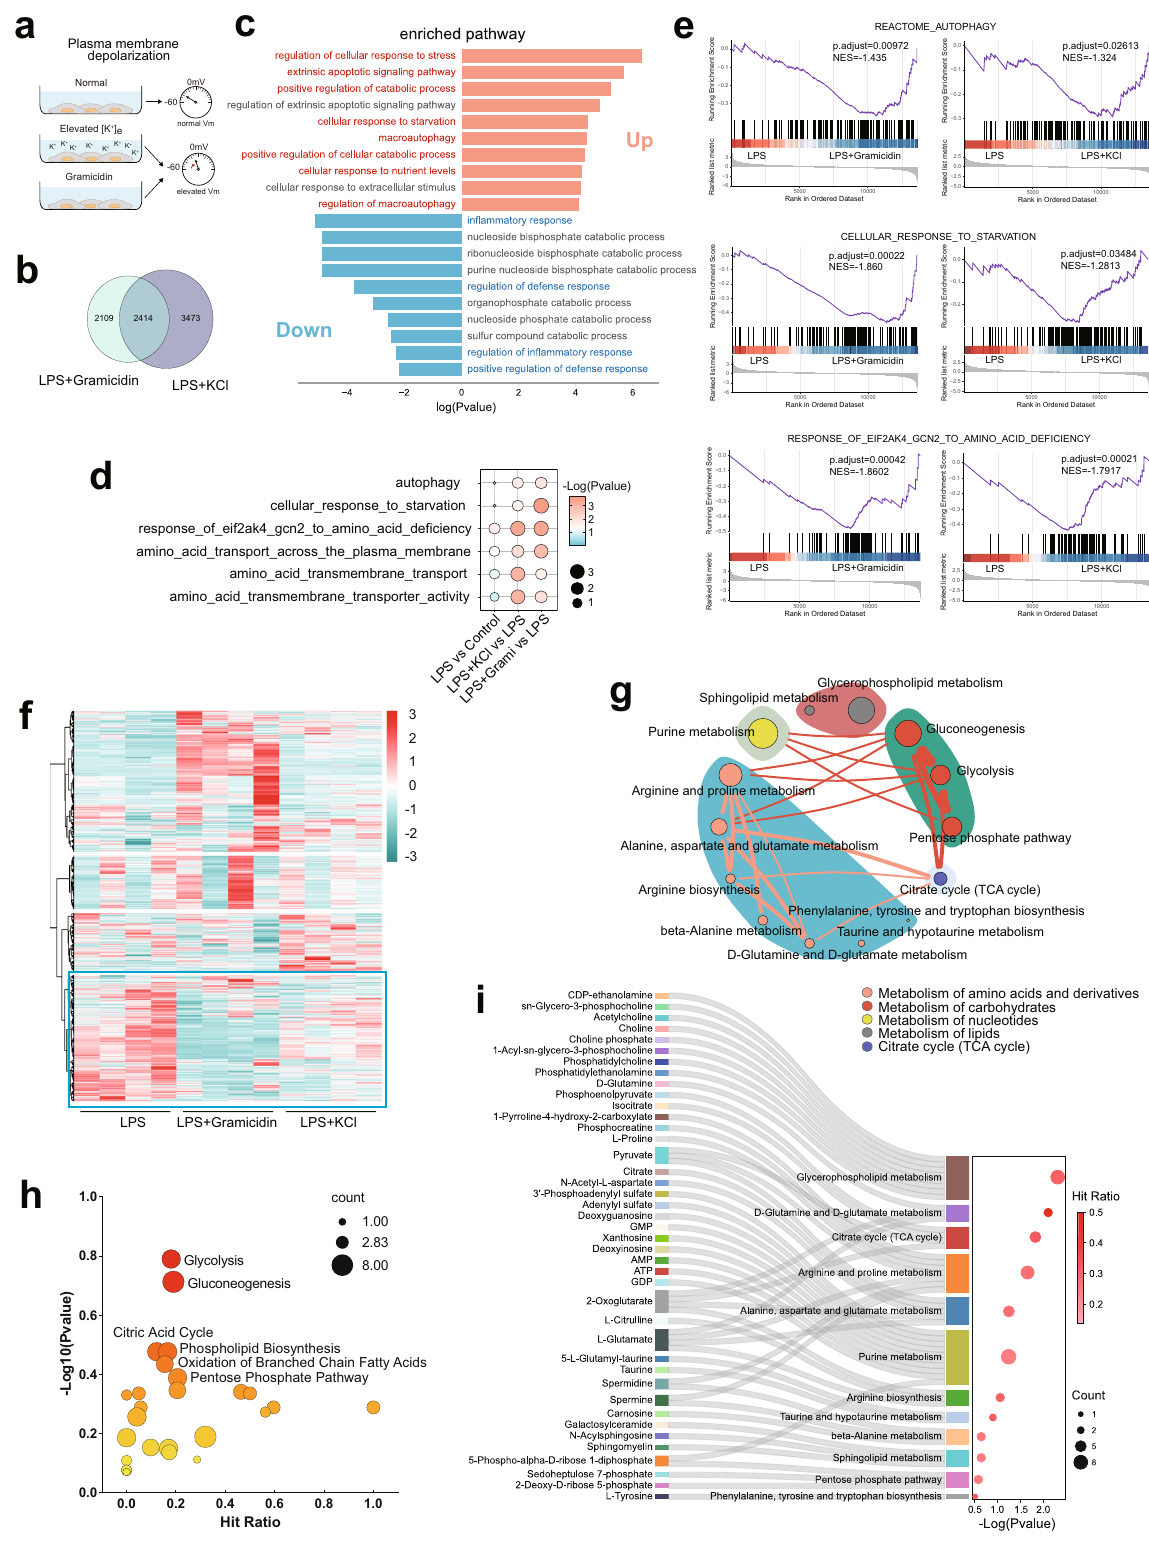
affecting cell viability (Supplementary Fig. 2C). Consistent with this, the Kir2.1 current was also abolished in Kir2.1-de fi cient macrophages (Fig. 2d, e), while the ability of bone marrow cells to differentiate into macrophages was unaffected (Supplementary Fig. 2D, E). Most important, we found a depolarized V m in both Kir2.1-de fi cient resting and activated macrophages (Fig. 2f and